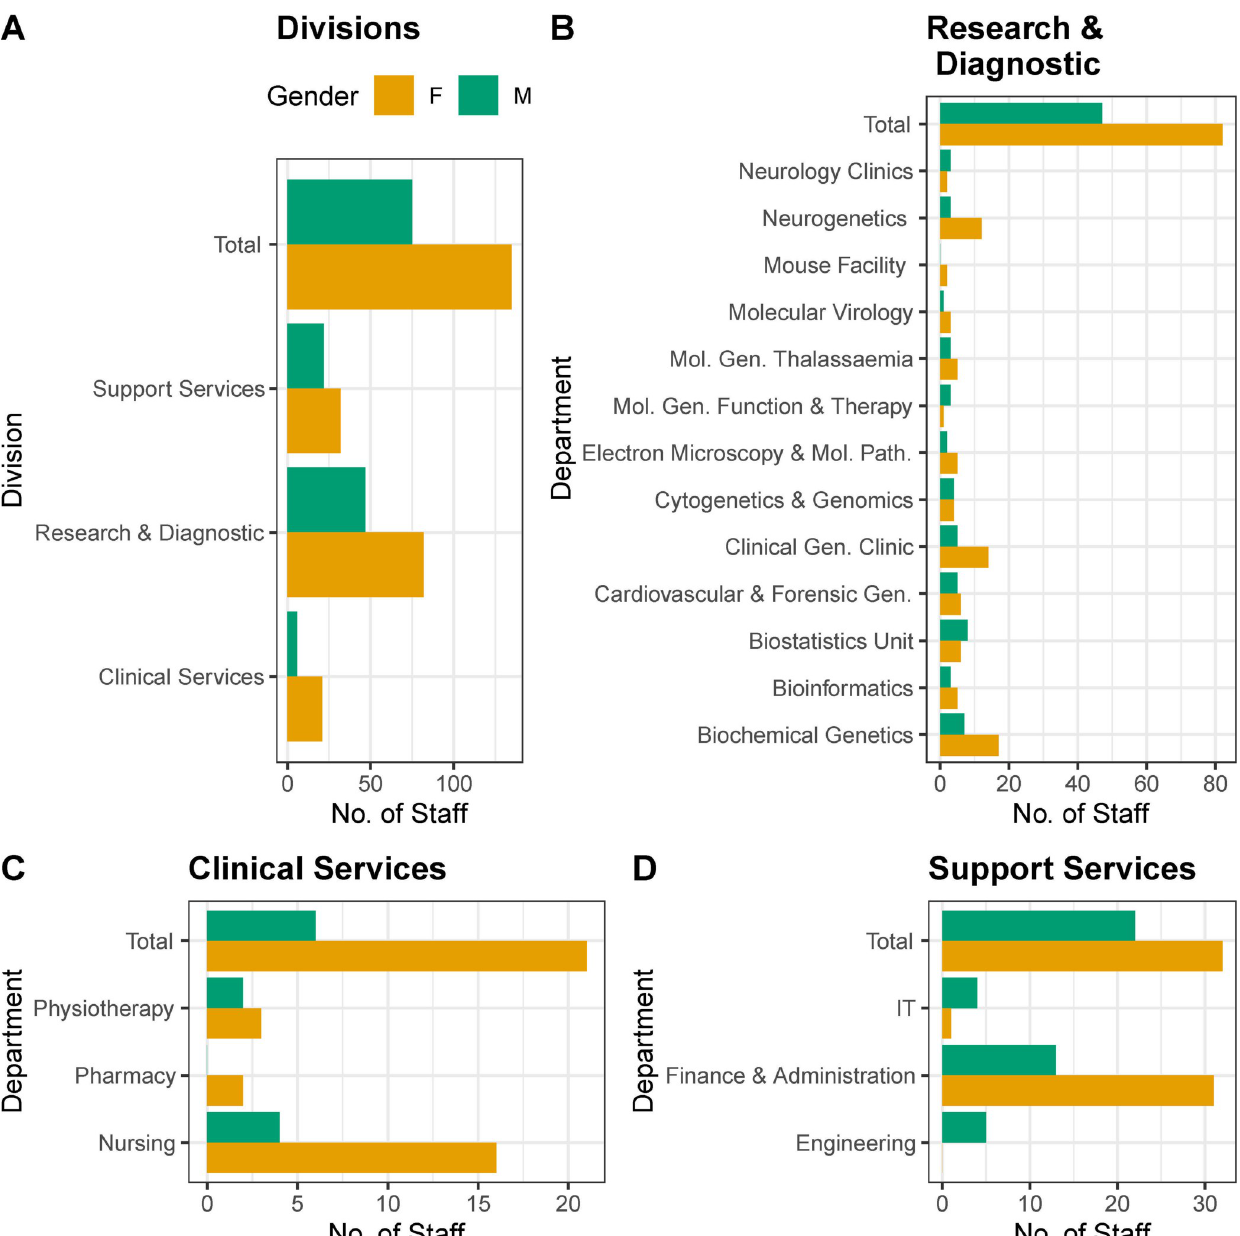
Fig 1. Gender distribution of employees in the CING. A. Histogram plots of the gender distribution of employees in the three divisions (Clinical Services, Research & Diagnostic and Support Services) in the CING. B. Histogram plots of the gender distribution of employees in the CING Departments (Clinics, Laboratories and Facilities). C. Histogram plots of the gender distribution of employees in the Clinical Services departments. D. Histogram plots of the gender distribution of employees in the Support Services departments of the CING. representation of females to males in the Engineering (100% males) and IT departments (20% vs 80%) in contrast, in the Finance & Administration Department, there are more females compared to males (70.45% vs 29.55%) as illustrated in Fig 1D (see S4 Table for group values). A Fisher’s exact test of independence showed that there was significant association between gender and department membership in the Support Services division (p-value = 0.0006922).